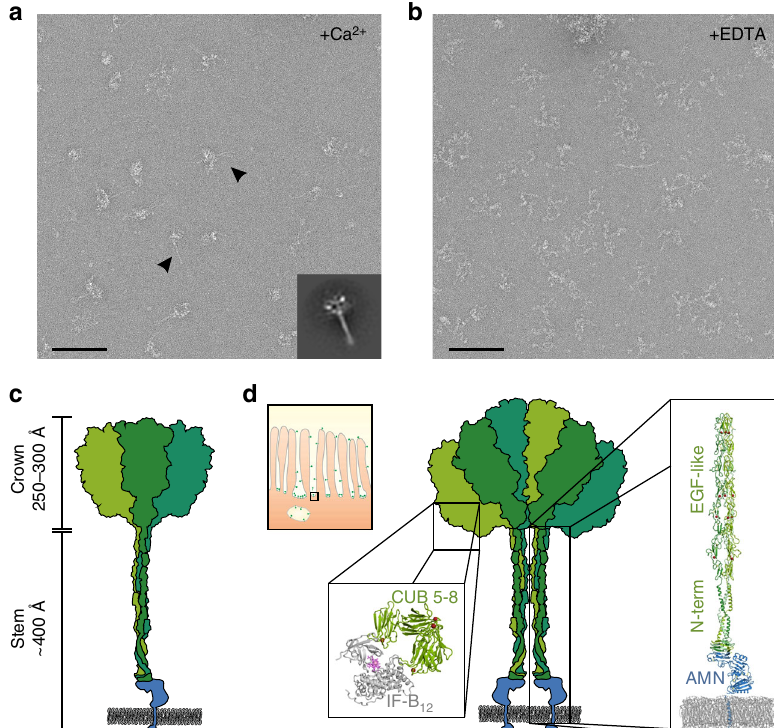
Fig. 4 Negative stain electron microscopy and modelling of full-length cubam. a Typical electron micrograph showing two different forms of cubam (marked by arrows) — a single-stem form with a small head domain and a double-stem form with a larger head domain. A 100 nm scale bar is shown in the lower left-hand corner. Class average of 758 particles of the double-stem form is shown in the lower right-hand corner. Meaningful class-averages of the single-stem form of cubam could not be obtained due to inhomogeneous particles. b Typical electron micrograph showing partly unfolded cubam in the presence of 10 mM EDTA. Ca 2 + -binding motifs are found in several of the CUB and EGF-like domains of cubilin. Receptor unfolding in the presence of EDTA suggests that Ca 2 + -binding serves to maintain the structural integrity of cubam. c Schematic representation of the single-stem form of cubam with approximate dimensions of “ stem ” and “ crown ” regions. d Schematic representation of the double-stem form of cubam. The top-left box shows a schematic representation of the cubam location the enterocyte brush-border membrane with approximate proportional sizes of cubam and the microvilli. The predicted IF-B 12 -binding region of cubam is marked by a box and the structure of CUB 5 – 8 -IF-B 12 12 is shown as enlargement with the B 12 structure visualised in the original purple colour. We anticipate that the stem of cubam is formed by AMN and the C-terminal region of cubilin including the eight EGF-like domains. The stem of cubam is marked by a box and a model of the stem is shown as